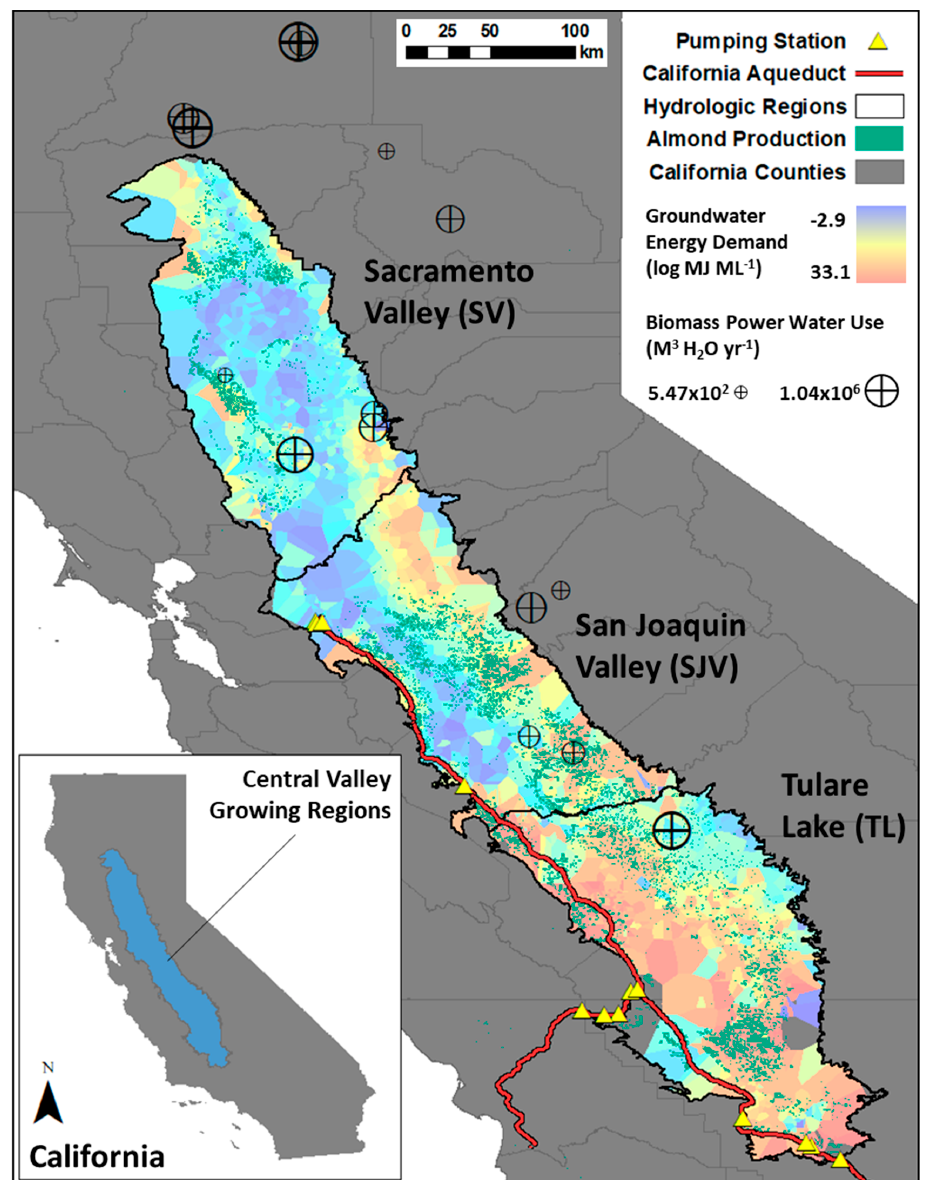
Figure 1. Energy demand for irrigation water delivery in the Central Valley, accounting for groundwater depth as a mean of test well measurements from 2012–2017 [7] and energy use in surface water pumping via the California Aqueduct, overlaid by almond production, biomass energy facilities and major irrigation infrastructure [8].